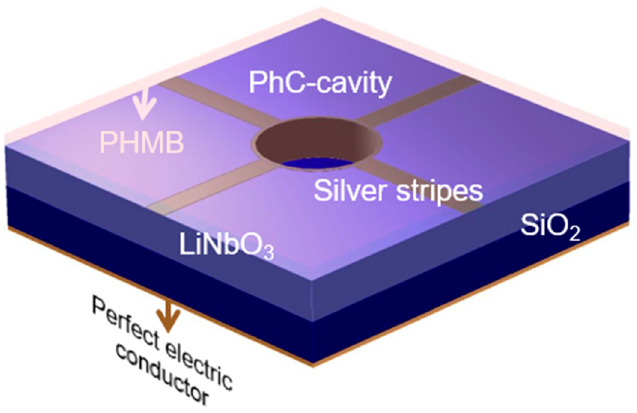
Figure 1. Design of the CO 2 gas sensor, showing the layout of different layers.